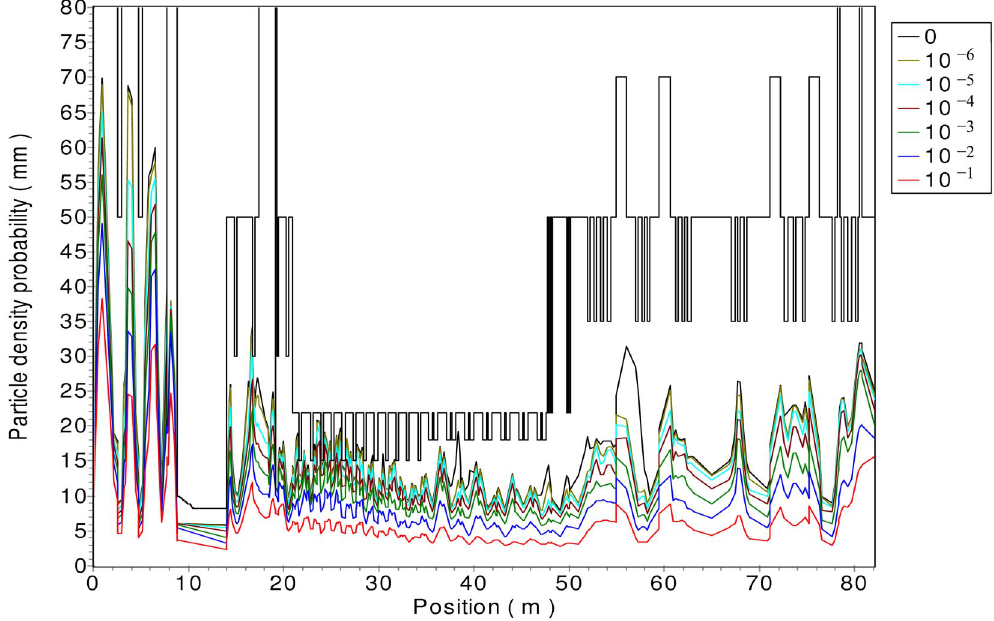
FIG. 5. (Color) Beam size radii along the linac. 10 (cid:3) 1 corresponds to 90% of the beam, 10 (cid:3) 2 ! 99% , 10 (cid:3) 3 ! 99 : 9% . . . and the last black one is the radial aperture.